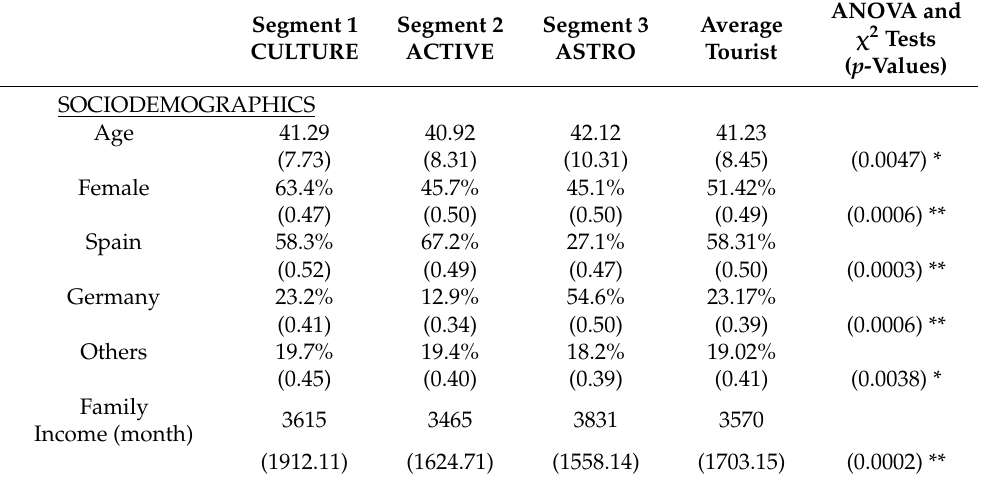
Table 5. Socioeconomic profile of tourists’ segments for stargazing land resources (standard devia- tions in